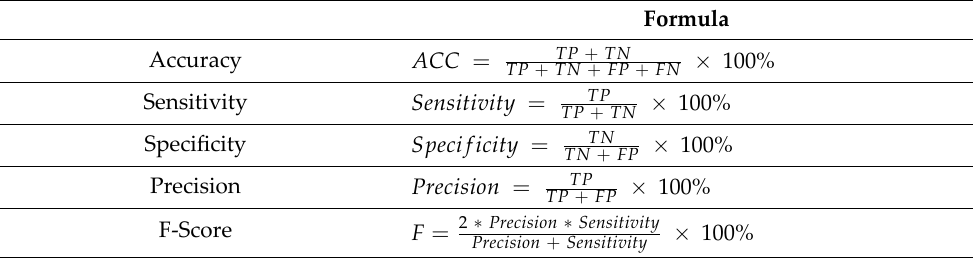
Table 7. Parameters for lung cancer diagnosis.